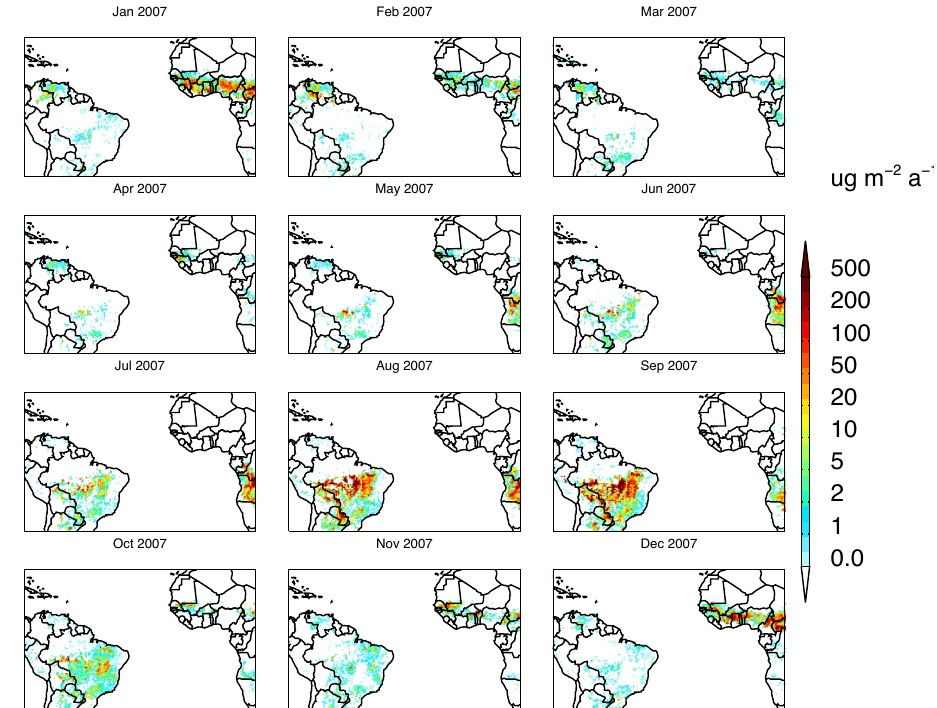
Fig. 4. Maps showing the mercury emissions from fire on the South American and African continent obtained from the GFED3 inventory for each month in 2007. It can clearly be seen that especially in August and September fire emissions are high on the South American continent.